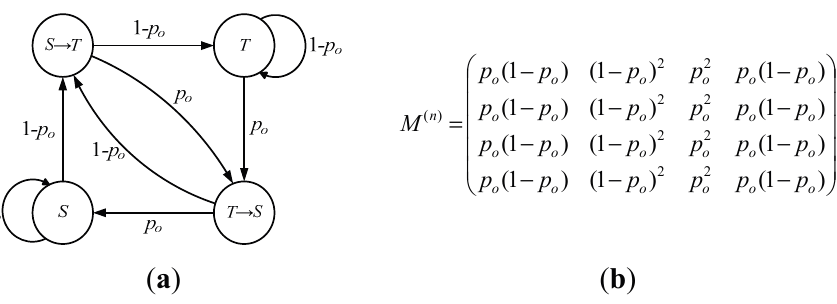
Figure 2. ( a ) The state transition diagram; ( b ) n-step transition probability matrix (n >